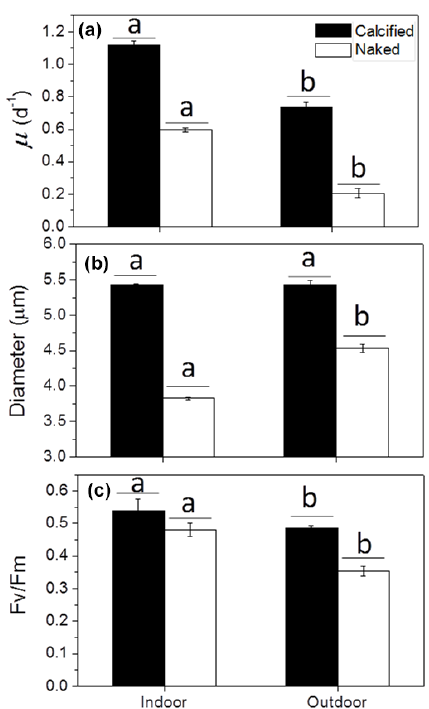
Figure 2. The specific growth rate ( µ ) (a) , diameter (b) and maxi- mum quantum yield (c) of PSII ( F v /F m ) of the calcified and naked cells of E. huxleyi grown in indoor and outdoor conditions. Differ- ent letters represent significant differences between the indoor and outdoor experiments. Different horizontal lines represent significant differences between the different strains. Table 1. Photosynthetic parameters of relative electron transport rate (Fig. 3) as a function of PAR; different letters represent sig- nificant differences ( P <0.05) among the calcified, decalcified and naked cells.